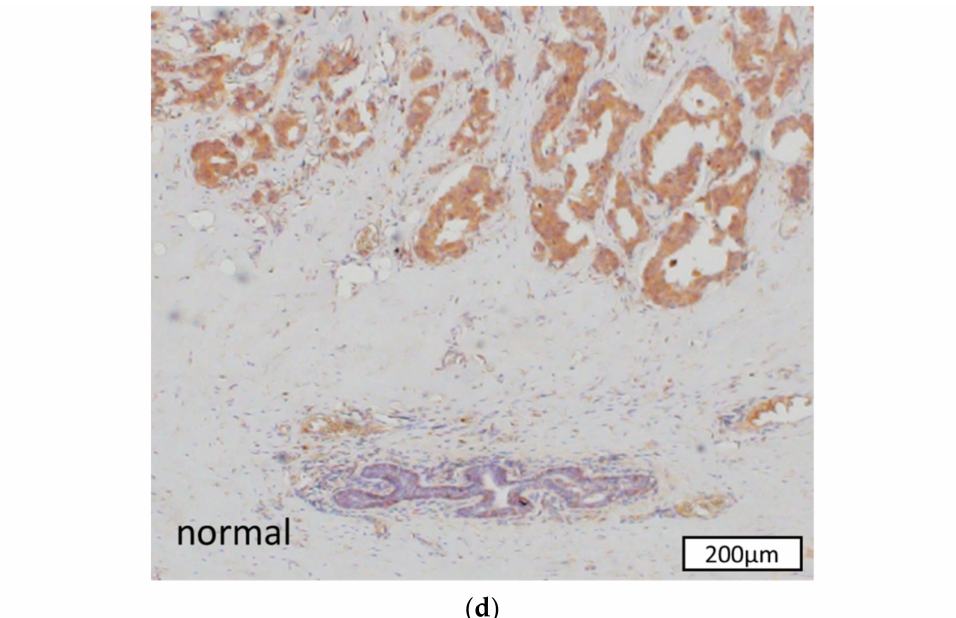
Figure 2. Immunohistochemical analysis of LAT1. Human placenta tissue was used as a positive control ( a ). Immunohistochemistry of LAT3. Human kidney tissue was used as a positive control ( b ). Immunohistochemical staining of LAT1. Relative immunointensity was scored from 0 to 3 (0 = no staining; 1 = week; 2 = moderate; and 3 = strong). Positive immunoreactivity was detected in both cytoplasm and cell membrane ( c ). LAT1 immunoreactivity was abundant in breast carcinoma cells but not in adjacent normal or non-tumorous ductal cells ( d